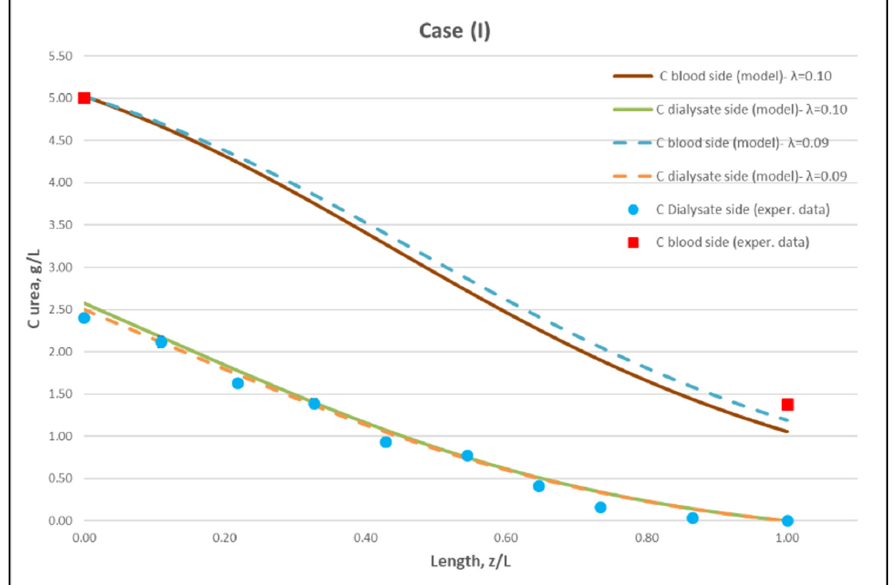
Figure 9. Comparison of measured local urea concentration C D in the dialysate-side, with model predictions, at flow rates Q Blood = 200 mL/min, Q Dialysate = 300 mL/min (Case I). The predicted blood-side urea concentration C B profile is also presented. The points ( ● and ■ ) designate measured values of urea concentration.